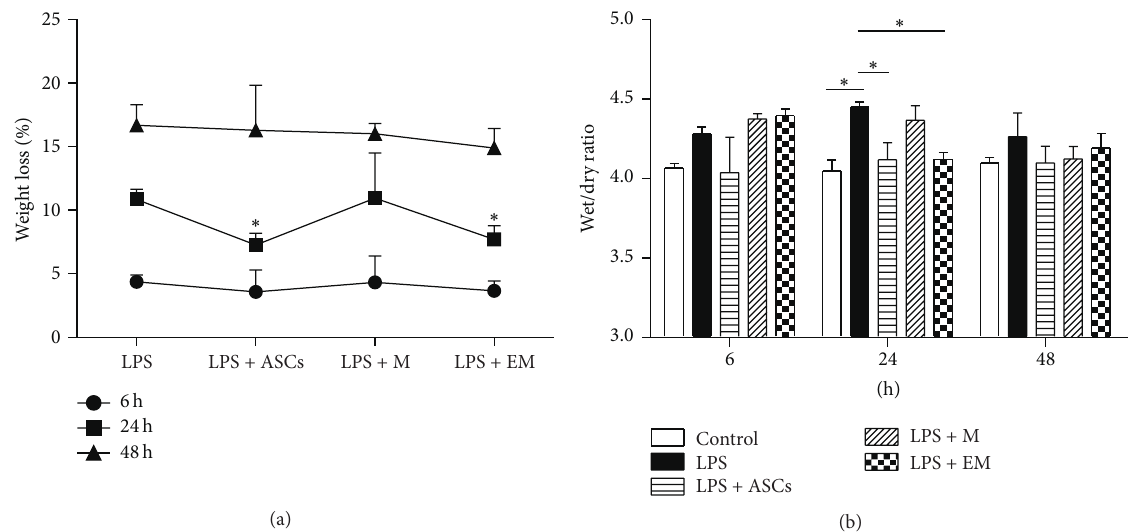
Figure 2: Infusion of educated macrophages (EM) reduces weight loss and pulmonary edema in mice treated with LPS. Animals were sacrificed before and at 6, 24, and 48 h after LPS or PBS treatment. (a) Percentage of weight loss was determined by the lost weight divided by the weight before LPS treatment. (b) Pulmonary edema was measured as the wet-dry ratio. M = macrophages. All data are expressed as mean ± SEM; 𝑛 = 4 per group. ∗ 𝑝 < 0.05